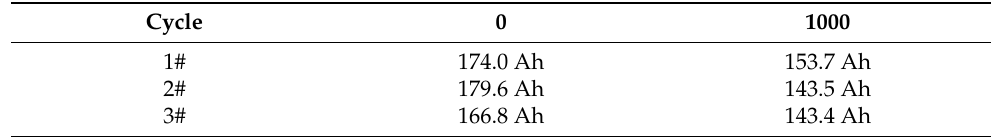
Table 1. The cell capacity of verification